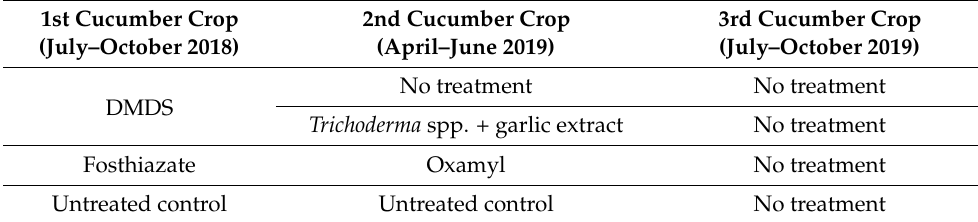
Table 1. Experimental trial scheme